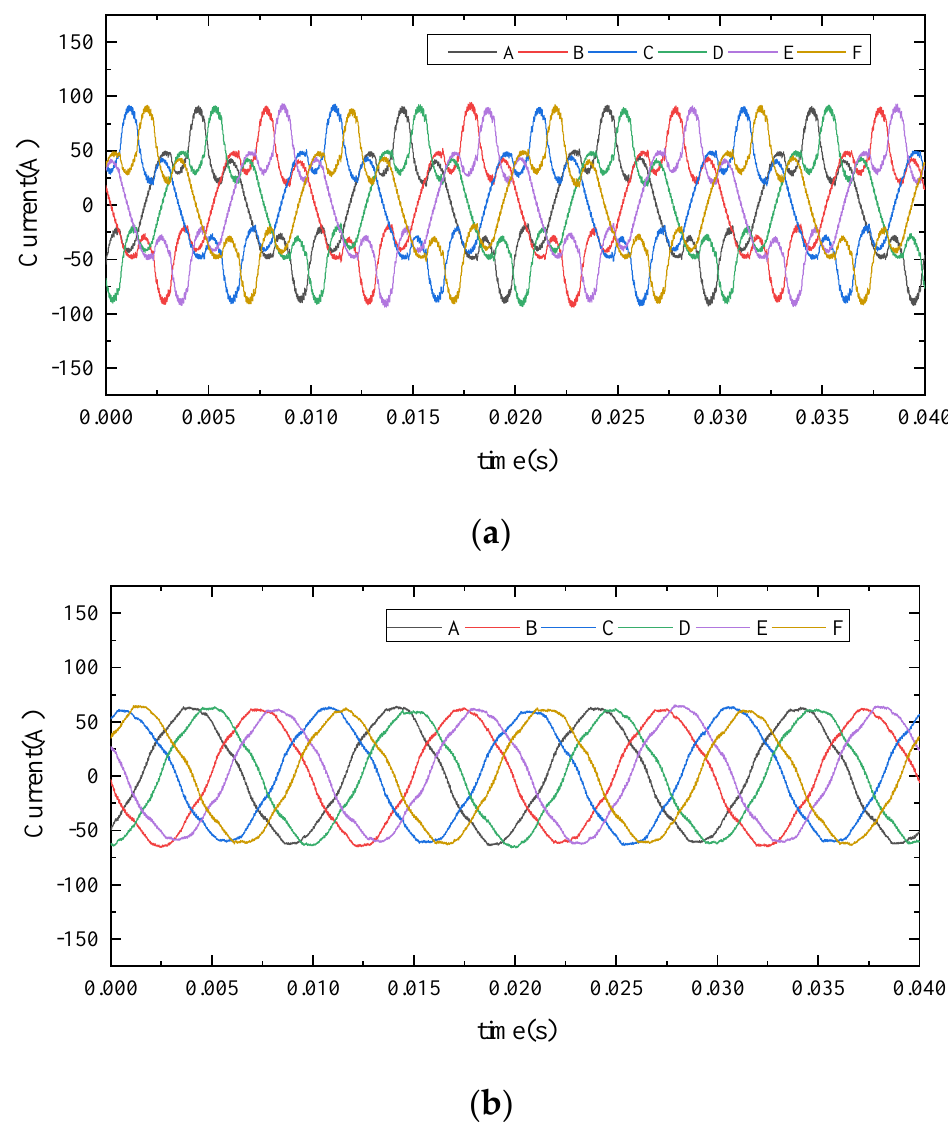
Figure 17. Dual three–phase current simulation diagram. ( a ) Traditional DTC current simulation diagram. ( b ) Low–harmonic DTC current simulation diagram.